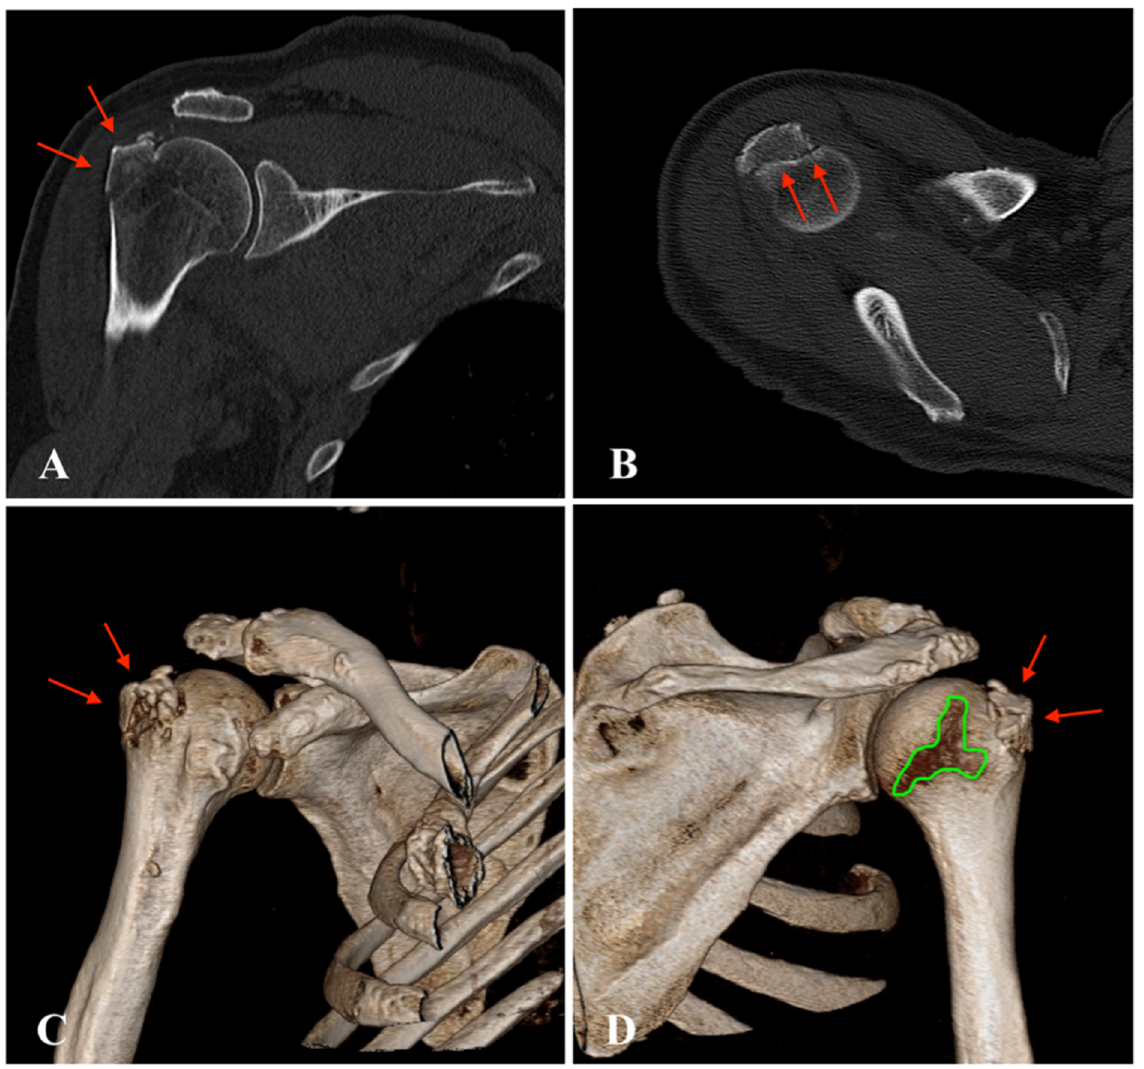
Figure 3. Computed tomography (CT) of the right shoulder after inferior dislocation: ( A ), coronal scan with greater tuberosity fracture (red arrows); ( B ), axial scan with greater tuberosity fracture (red arrows); ( C ), anterior 3D reconstruction with nearly undisplaced greater tuberosity fracture (red arrows); ( D ), posterior 3D reconstruction with nearly undisplaced greater tuberosity fracture (red arrows) and visible bare area of the humeral head (green area) .